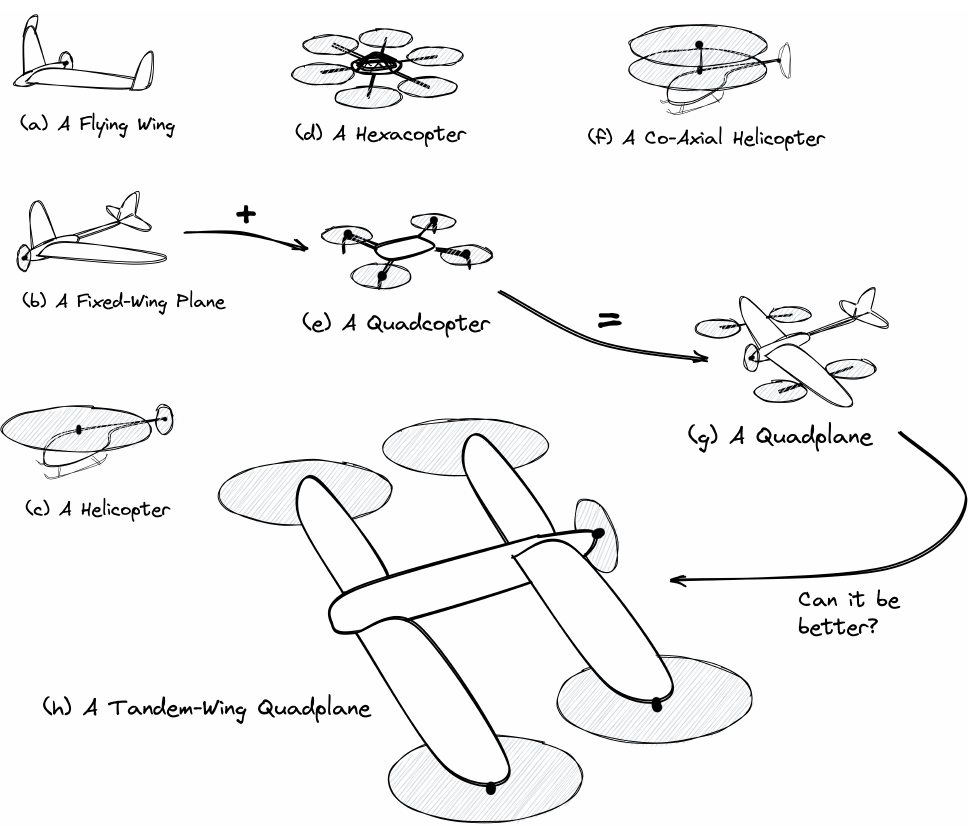
Figure 4. An overview of popular UAV